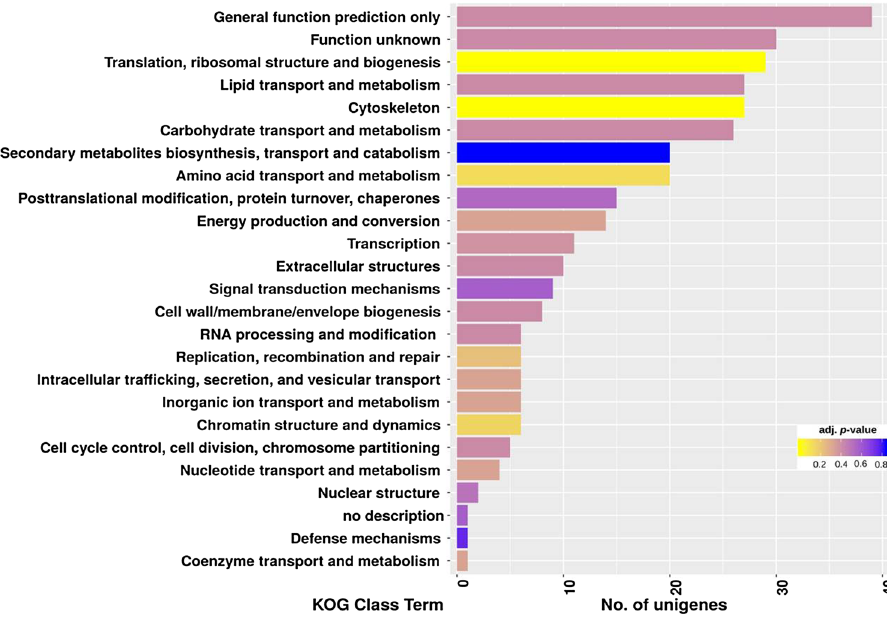
Figure 5. EuKaryotic Orthologous Groups (KOG) class enrichment analysis for P. indica DEGs under salt stress. Bars represent the number of unigenes for each KOG class (y-axis) found in the transcriptome. The significance level represented is based on adjusted p -value i.e. padj <